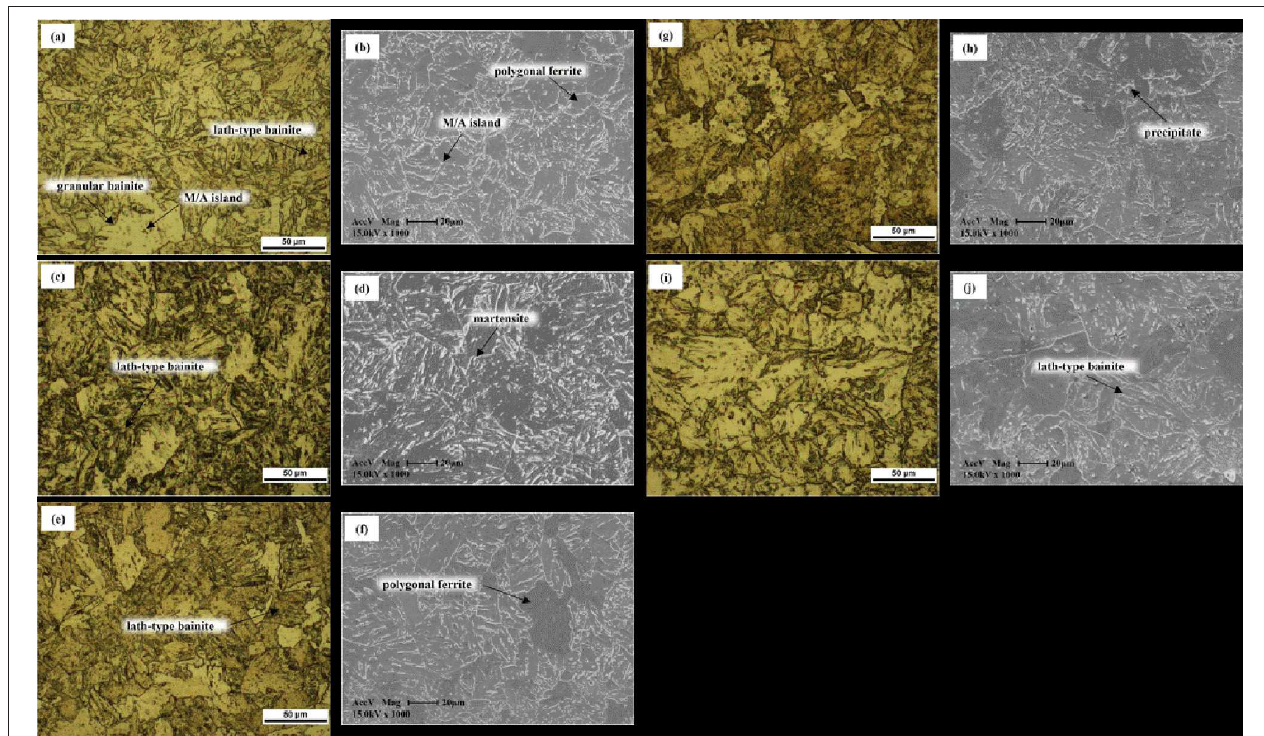
FIGURE 1 | Optical microstructures and SEM images of CB10 steel at various tempering temperatures: (a) optical microstructures as rolled, (b) SEM of CB10 steel as rolled, (c) optical microstructure of CB10 steel tempered at 250 ◦ C, (d) SEM of CB10 steel tempered at 250 ◦ C, (e) optical microstructure of CB10 steel tempered at 450 ◦ C, (f) SEM of CB10 steel tempered at 450 ◦ C, (g) optical microstructure of CB10 steel tempered at 600 ◦ C, (h) SEM of CB10 steel tempered at 600 ◦ C, (i) optical microstructure of CB10 steel tempered at 670 ◦ C, (j) SEM of CB10 steel tempered at 670 ◦